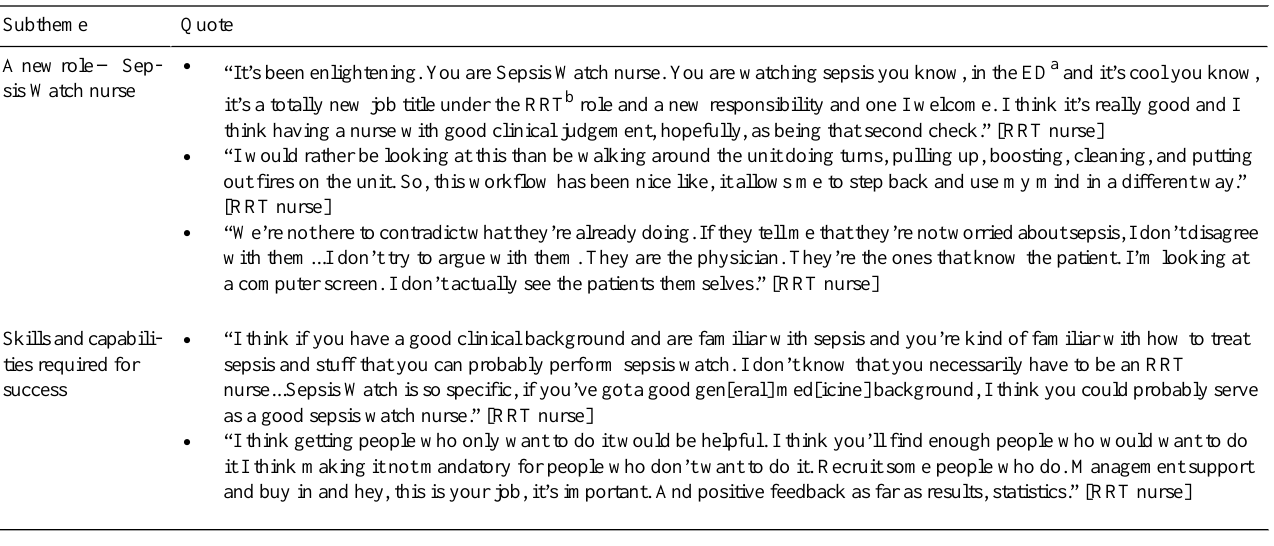
Table 6. Representative quotations on workforce